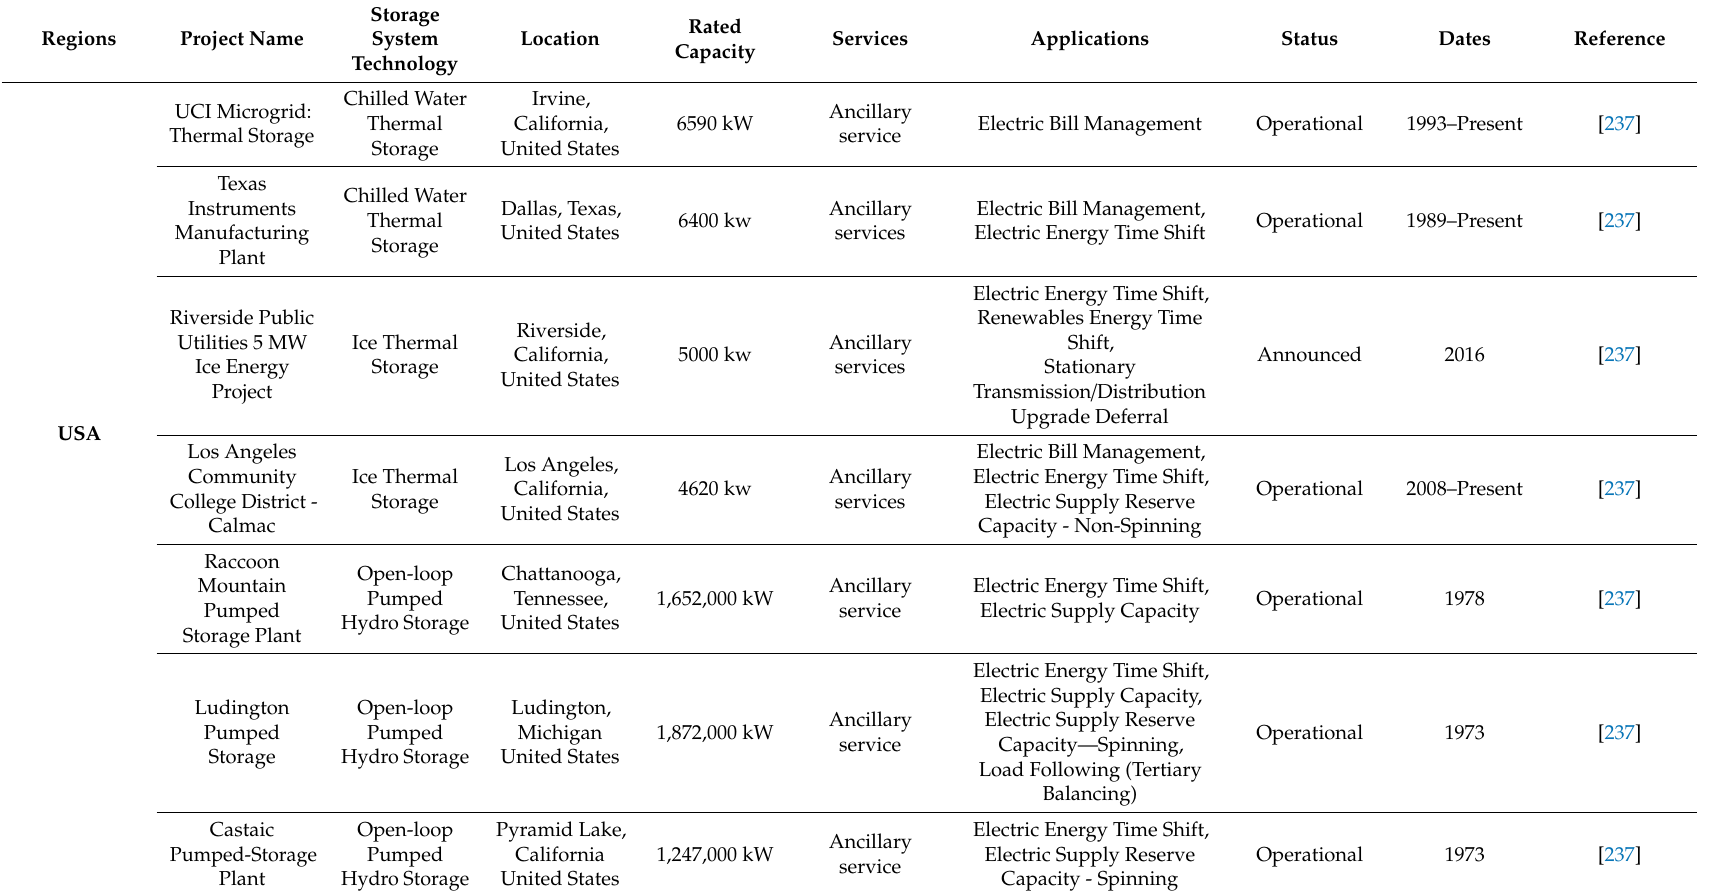
Table 17. The current scenario of energy storage projects around the